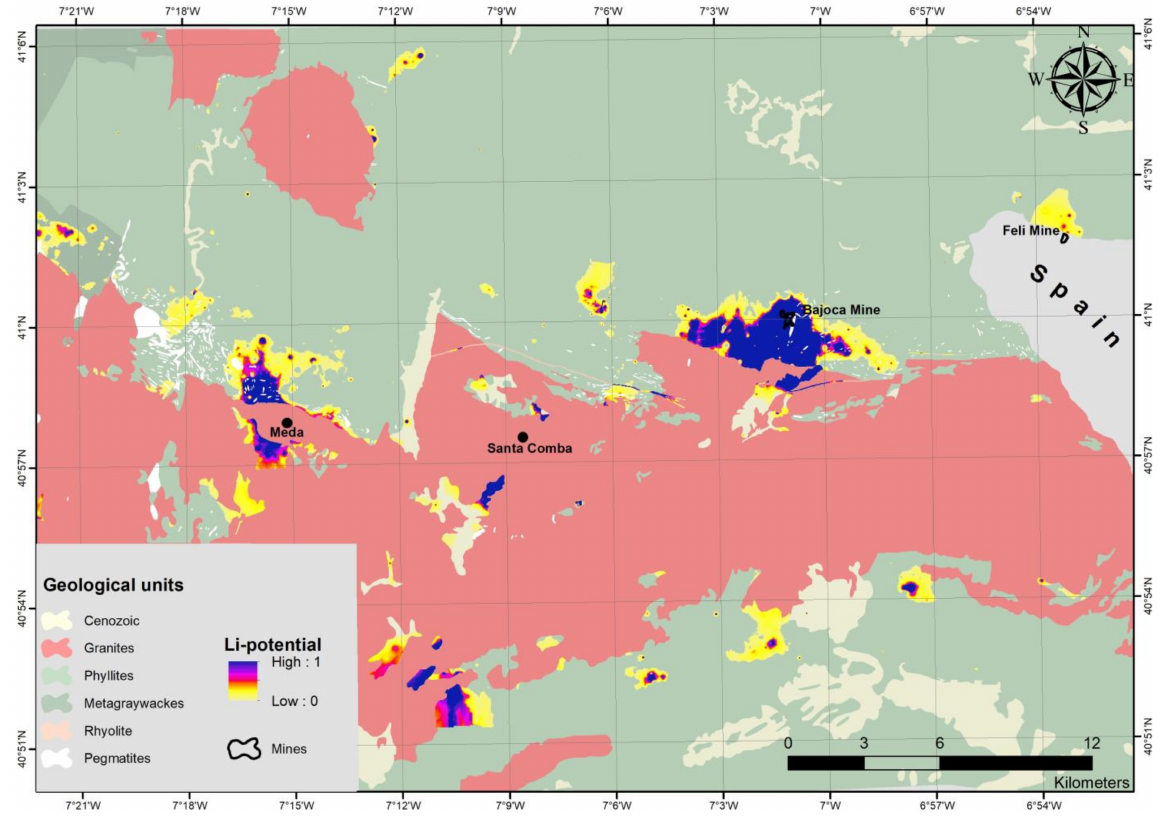
Figure 5. Probability map of Li mineralisation across the study area as a result of the geological/geochemical modelling approach (without remote sensing